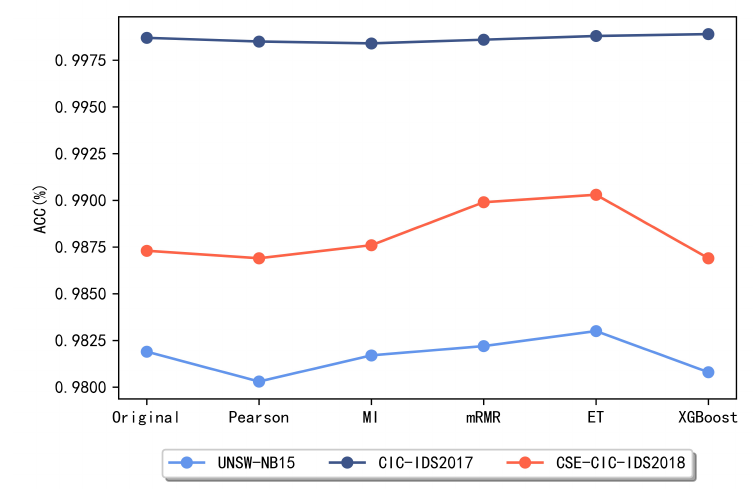
Figure 3. Comparison of accuracy of different methods.